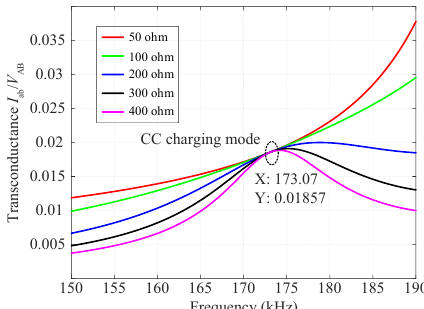
Figure 15. Simulated transconductance of the LCC-parallel compensation